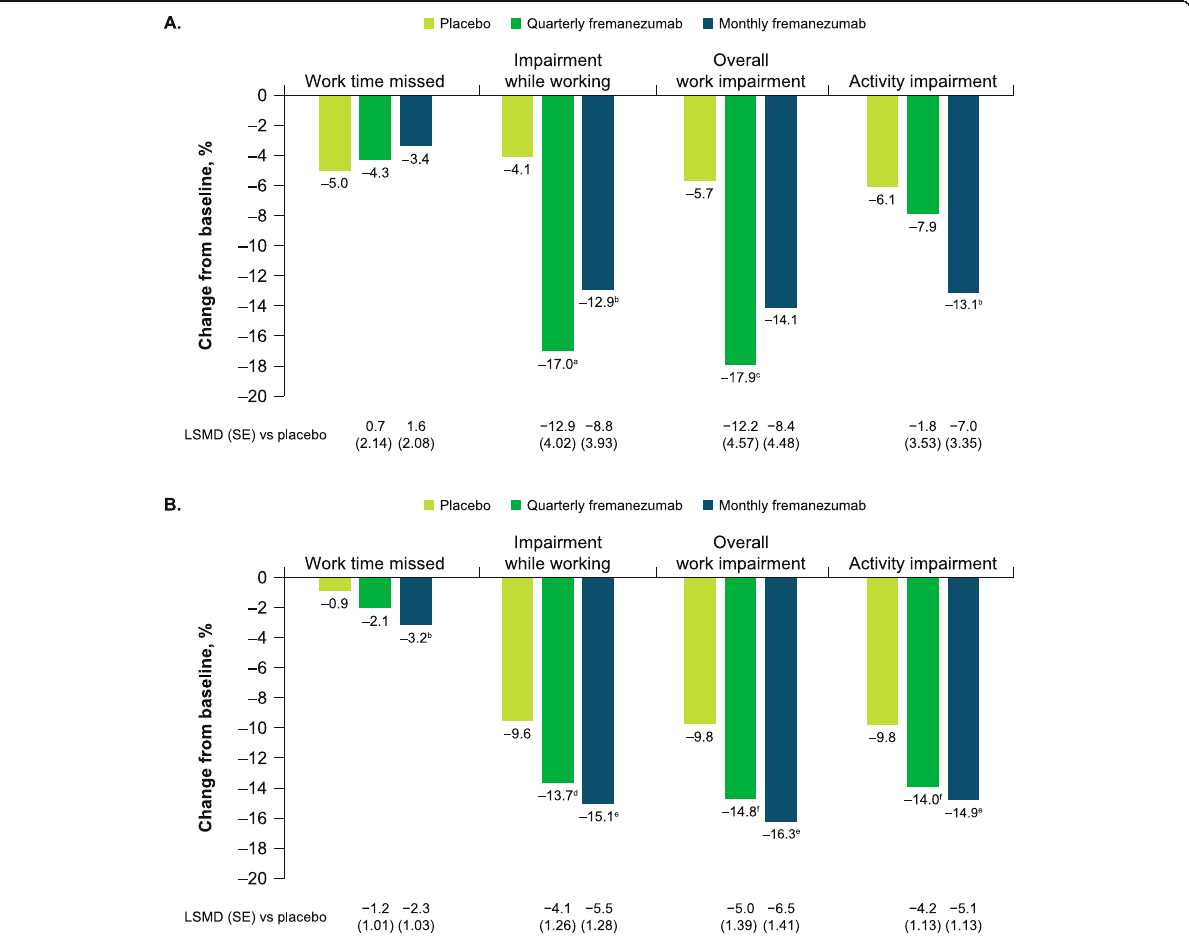
Fig. 8 Change in WPAI domain scores in A ) participants aged ≥ 60 years and B ) overall population. WPAI, Work Productivity and Activity Impairment; LSM, least-squares mean; LSMD, least-squares mean difference; SE, standard error. Data shown are the LSM changes from baseline in WPAI domain scores during 12 weeks of double-blind treatment. a P < 0.005 vs placebo. b P < 0.05 vs placebo. c P < 0.01 vs placebo. d P ≤ 0.001 vs placebo. e P < 0.0001 vs placebo. f P < 0.0005 vs placebo